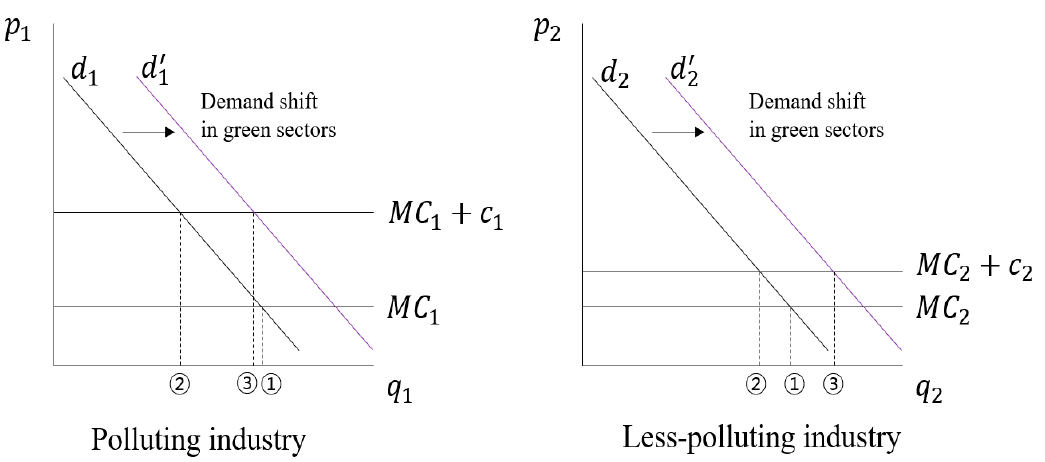
Figure 2. The e ff ects of environmental regulations in industries di ff erentiated by the level of Figure 2. The effects of environmental regulations in industries differentiated by the level of pollution.